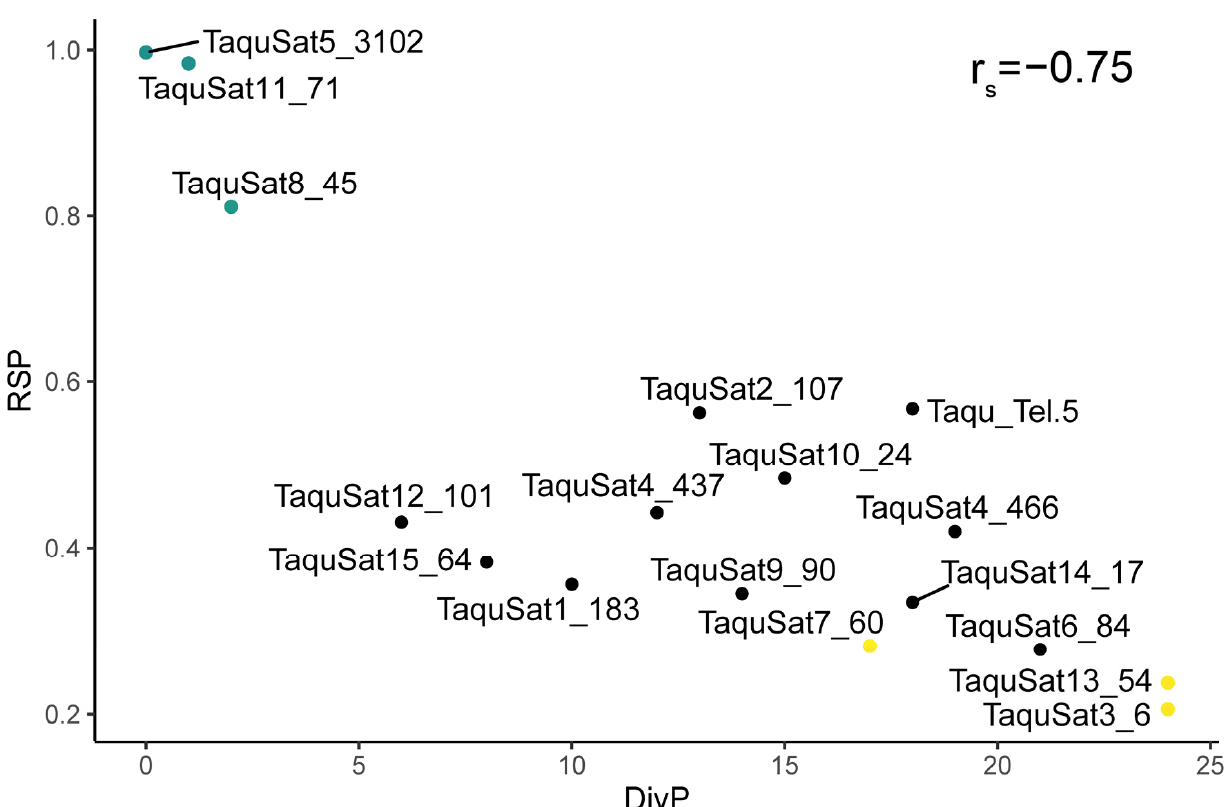
Figure 2. Correlation between the homogenization (RSP) and degeneration (DivP) indices of T. aquitania satDNA families. Recently expanded families are in blue and highly divergent and degenerated families are in yellow .